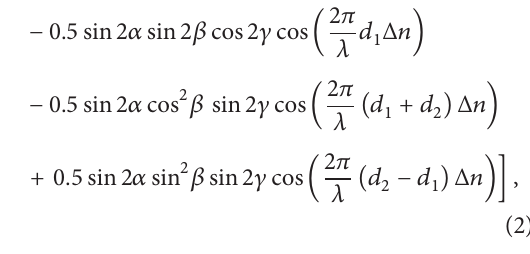
Figure 4: (a) The transmission spectrum of the polarizer-crystal-crystal-analyzer system quartz crystals; 𝑑 1 = 𝑑 2 = 2.127 mm; 𝛼 = 60 ∘ ; 𝛽 = 0 ∘ ; 𝛾 = 90 ∘ . (b) The transmission spectrum of the polarizer-crystal-crystal-analyzer system quartz crystals; 𝑑 𝛽 = 0 ∘ ; 𝛾 = 30 ∘ . (c) The transmission spectrum of the polarizer-crystal-crystal-analyzer system quartz crystals; 𝑑 𝛽 = 30 ∘ ; 𝛾 = 30 ∘ . (d) The transmission spectrum of the polarizer-crystal-crystal-analyzer system quartz crystals; 𝑑 𝛼 = 60 ∘ ; 𝛽 = 0 ∘ ; 𝛾 = 60 ∘